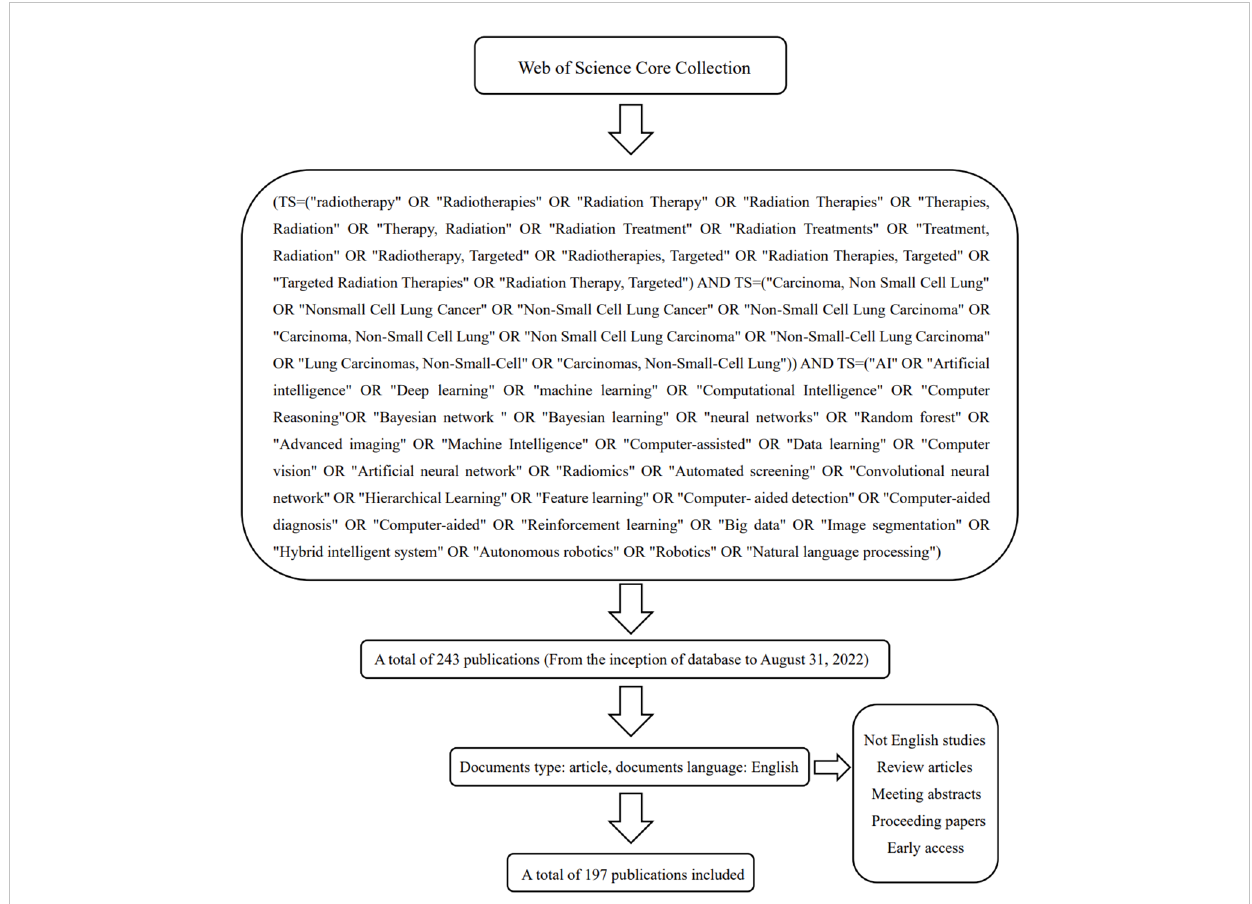
FIGURE 1 The search strategies of our bibliometric analysis, TS: Topic, which includes title, abstract, author keywords and additional